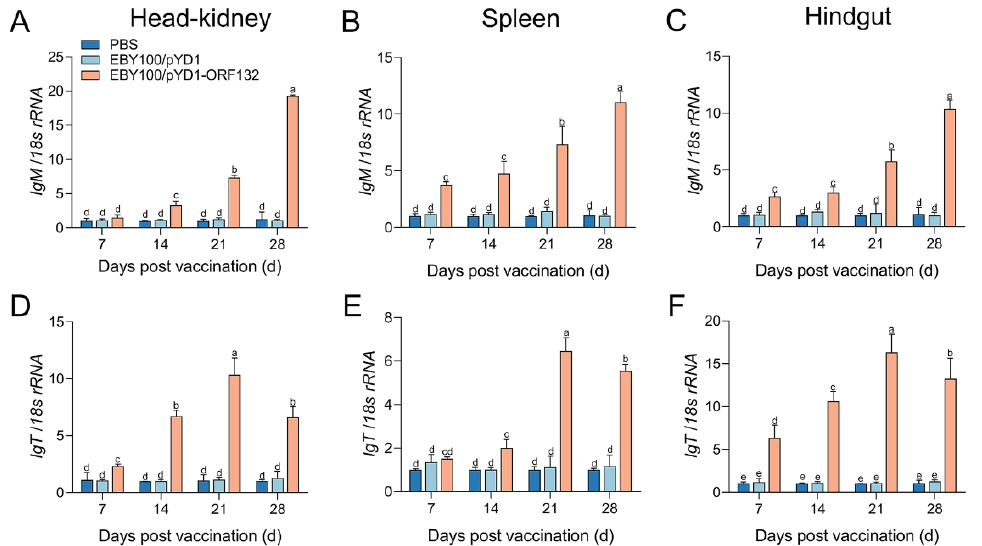
Figure 3. mRNA expression levels of IgM and IgT in the head–kidney ( A , D ), spleen ( B , E ), and hindgut ( C , F ) after the oral vaccination. Bars with different letters were significantly different according to Duncan’s multiple range ( p < 0.05).